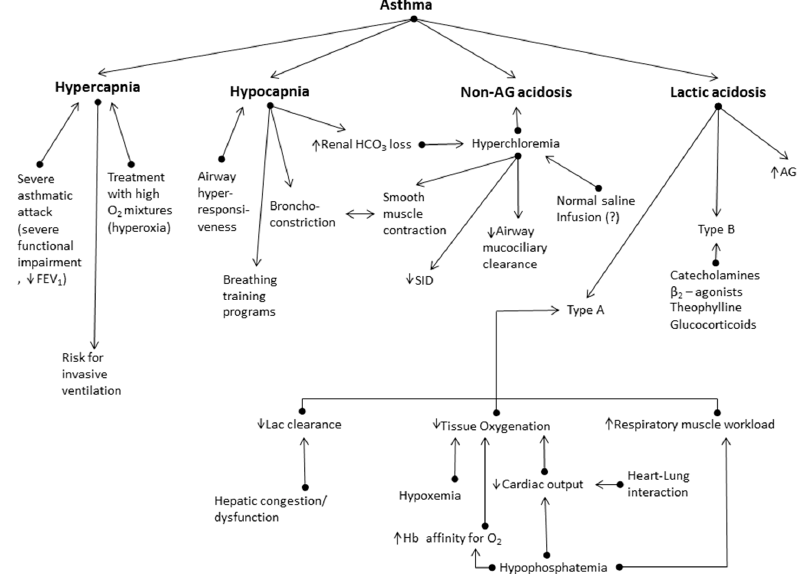
Figure 1. Acid-base disorders in asthma. FEV 1 = forced expiratory volume in 1 s. AG = anion-gap.